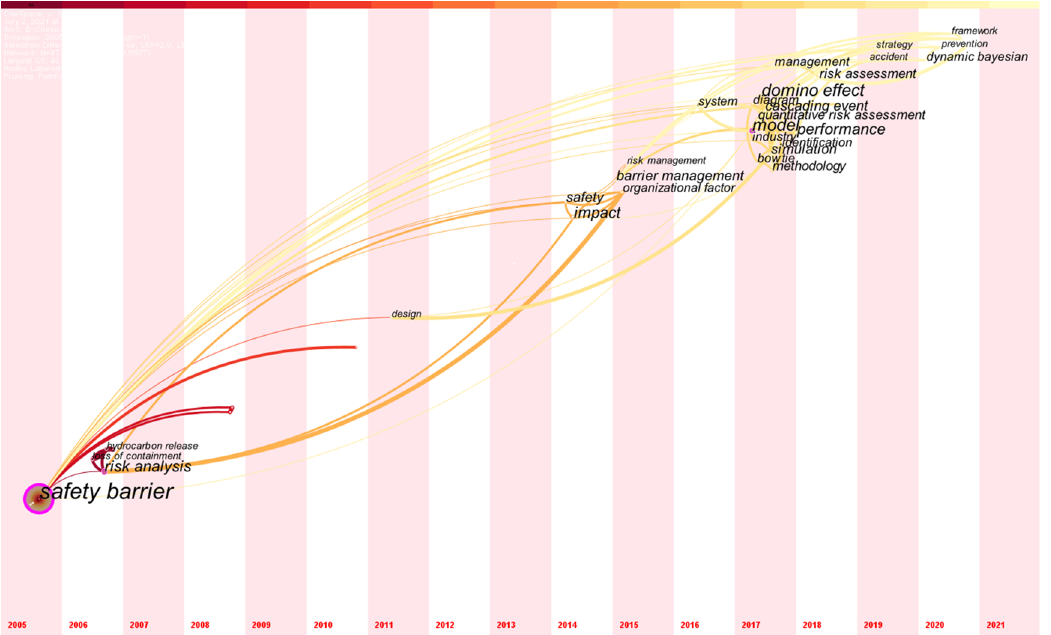
Figure 10. Mapping of keyword co-occurrences.